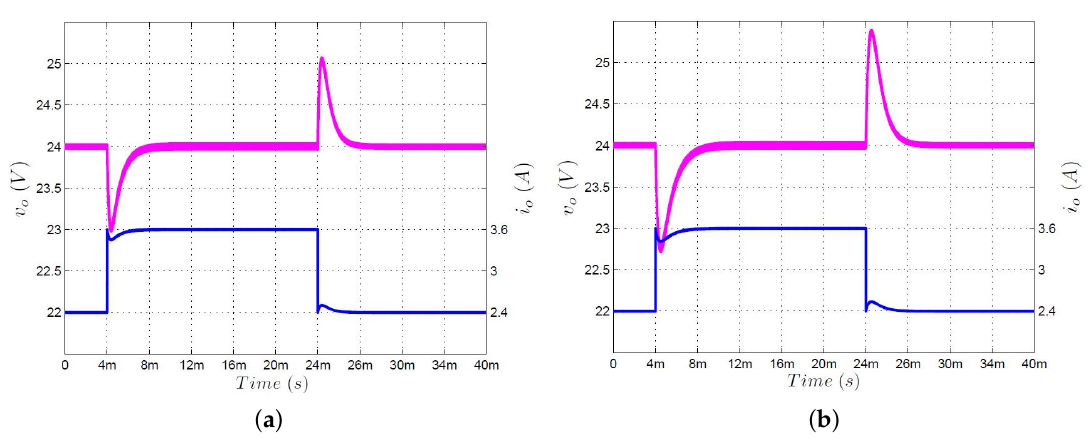
Figure 8. Simulated response of the boost converter under output current transients of 2 A with the LMI-Fuzzy controller ( F LMI − Fuzzy ) and LMI robust Controller ( F LMI ). ( a ) Voltage response v o with F LMI − Fuzzy . ( b ) Voltage response v o with F LMI [9].